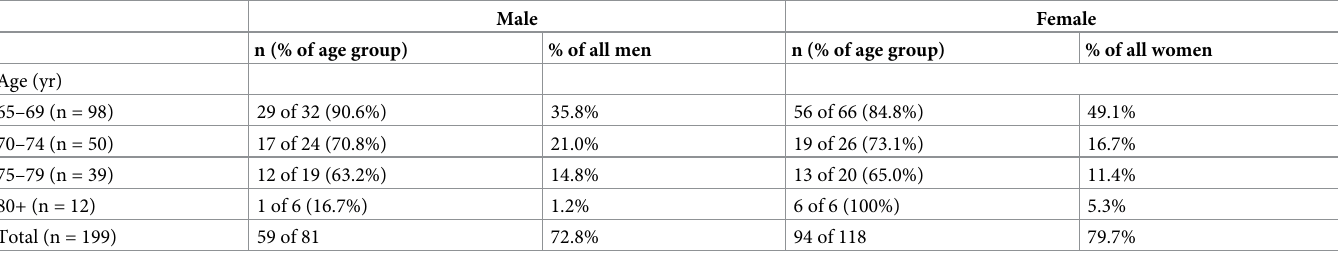
n number of subjects, fulfillment of WHO recommendations for moderate PA for people aged 65 and older: � 150 minutes moderate PA or � 75 minutes vigorous PA or an equivalent combination per